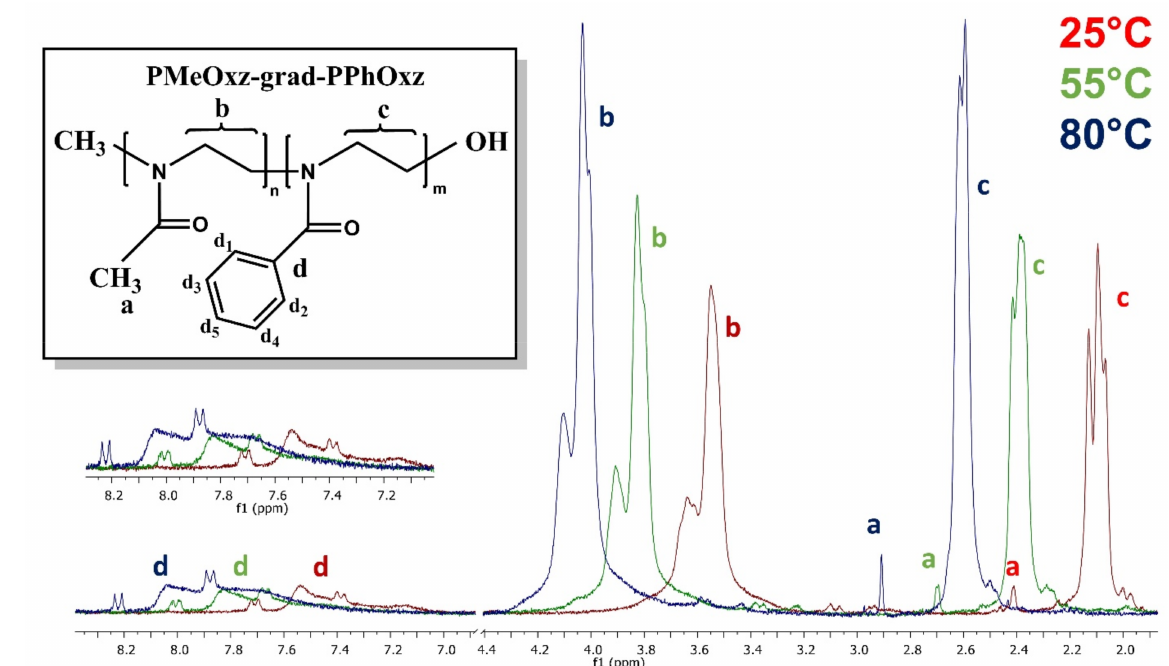
Figure 11. Comparison of 1 H-NMR spectra of PMeOxz 72 -grad-PPhOxz 28 GC at various temperatures. The red, green, and blue letters refer to the protons of PMeOxz 72 -grad-PPhOxz 28 GC at 25 ◦ C, 55 ◦ C and 80 ◦ C, respectively.